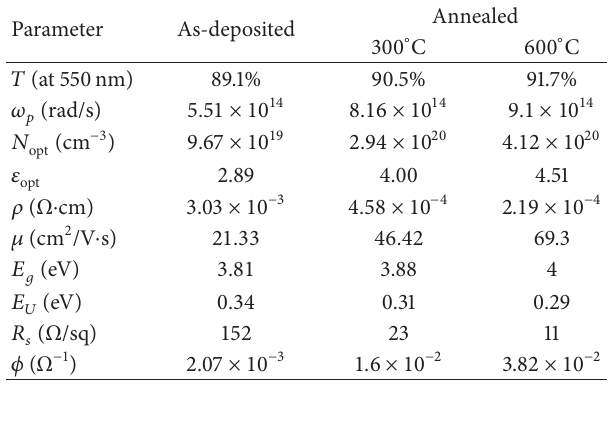
Table 2: Electro-optical parameters of as-deposited and annealed ITO thin films.